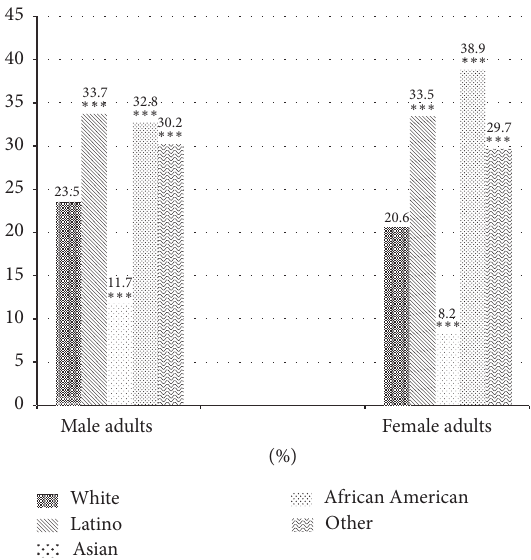
Figure 1: The prevalence (%) of obesity of adults in California in the United States, 2011-2012, by ethnicity and gender. ∗∗∗ 𝑃 < 0.001 versus Whites. Notes . 𝑃 < 0.001 for all ethnic groups versus Asians for both sexes. Not statistically significant (NS) for Latinos versus AAs, NS for the others versus AAs among men; 𝑃 < 0.01 for Latinos versus AAs and 𝑃 < 0.001 for the others versus AAs among women. NS for Latinos versus the others among men; 𝑃 < 0.01 for Latinos versus the others among